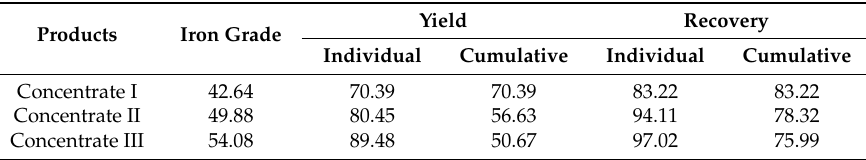
Table 3. Compositions of concentrates and tailing slag (wt %).